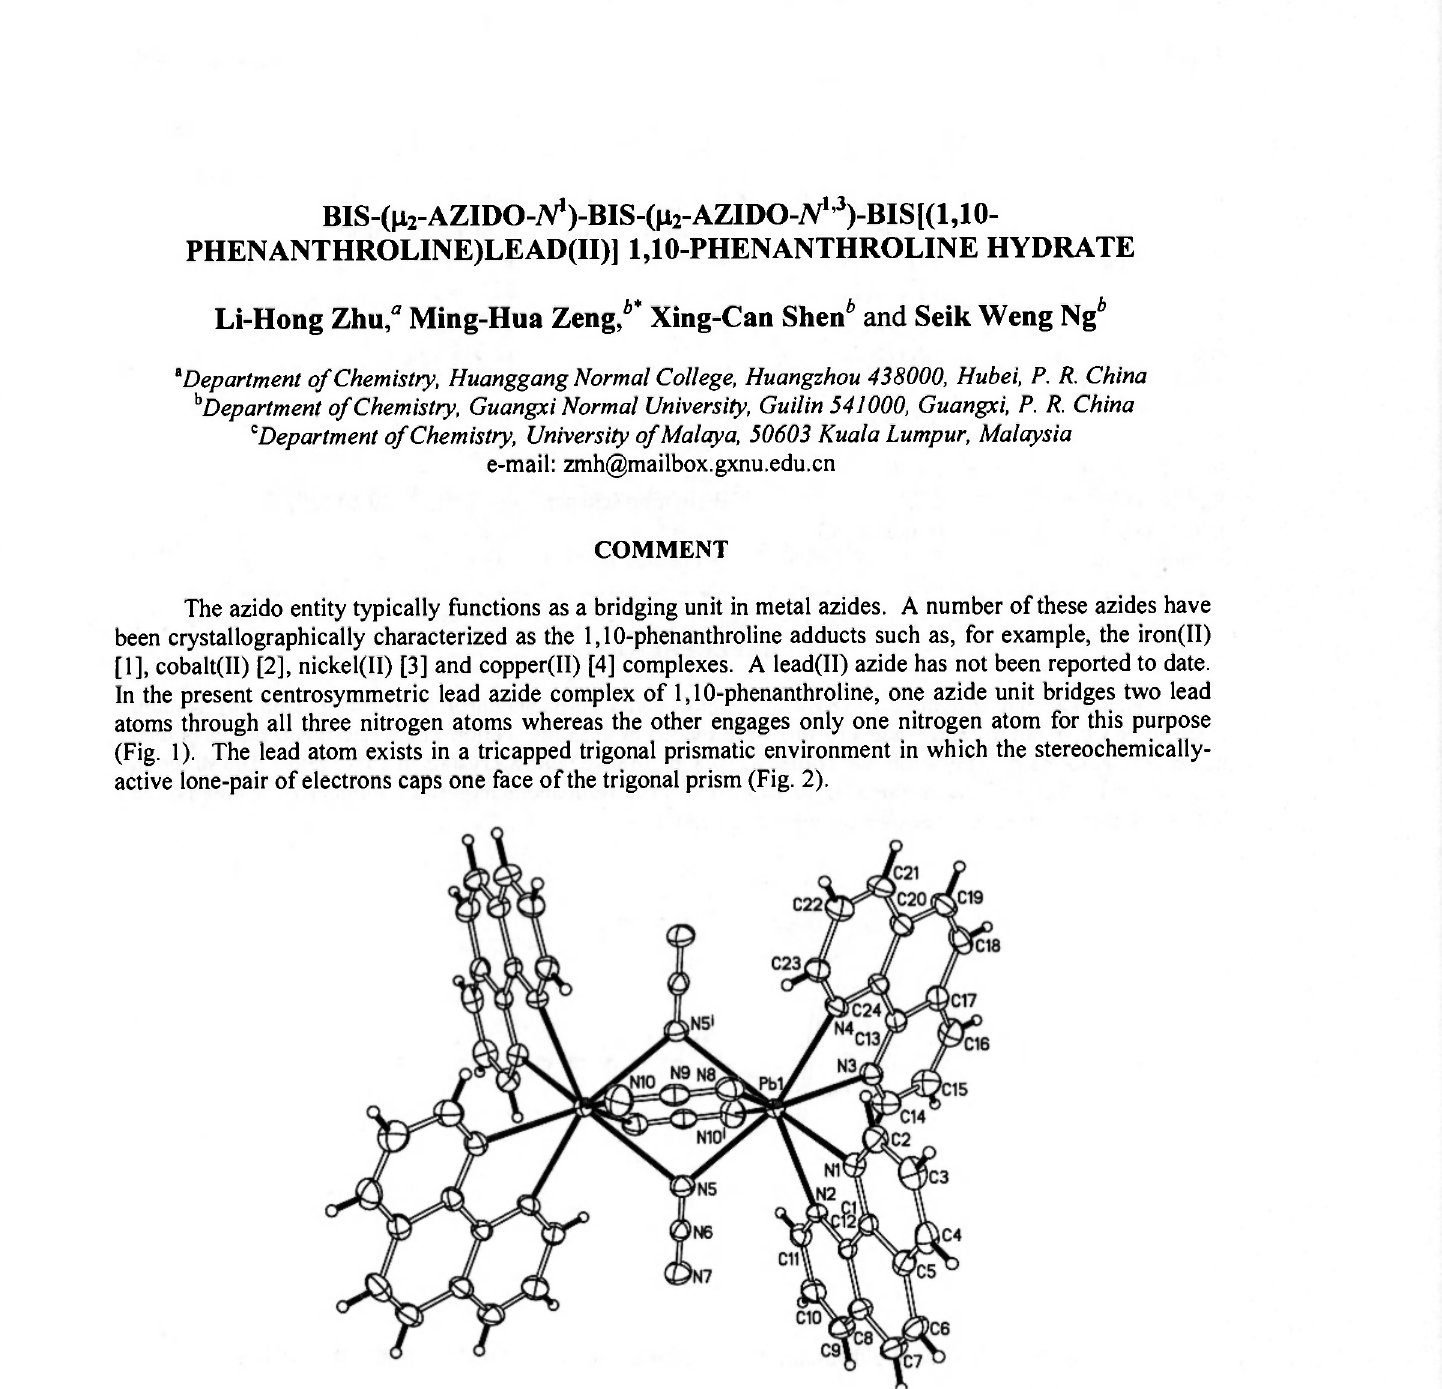
Fig. 1. ORTEP plot of (C 12 H 8 Ν 2 ) 4 (Ν·0 4 Ρ^(: Ι2 Η8Ν 2 Ή 2 Ο. The lattice C, 2 H 8 N 2 and H 2 0 molecules are not shown. Selected bond distances and angles: Pbl-N 12.623(5), Pbl-N22.695(5), Pbl-N32.732(5), Pbl-N 42.742(5), Pbl-N 52.741(7), ΡΜ-Ν5* 2.871(7), Pbl-N 82.790(7), Pbl-N10' 2.856(9) A; Nl-Pbl-N 262.0(2), Ν1-Pbl-N3 84.7(2), Nl-Pbl-N4 83.3(2), Nl-Pbl-N5 96.9(2), Nl-Pbl-N5' 146.5(2), N l - P b